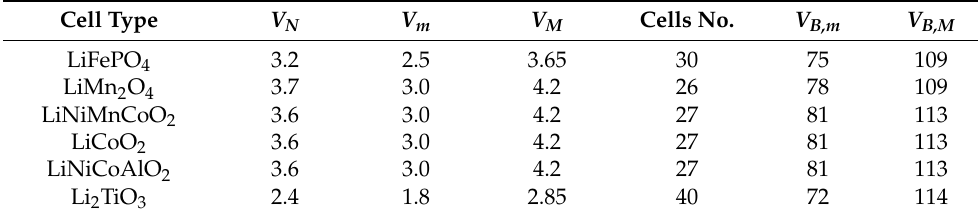
Table 1. Features of lithium